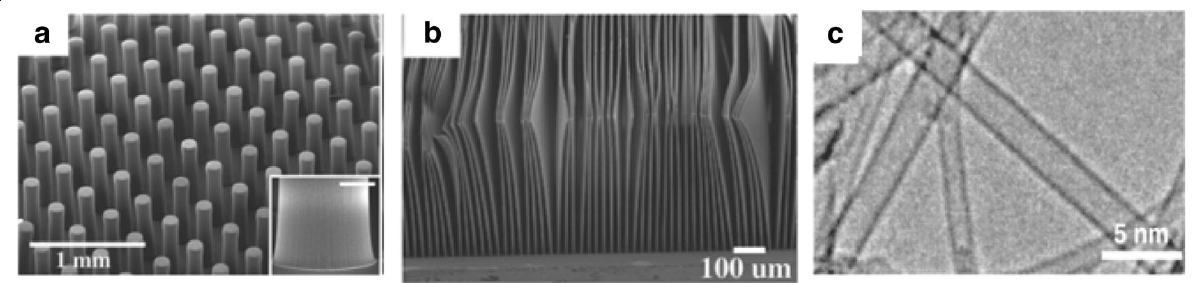
Fig. 31 a , b SEM images of SWCNT forests grown using water assisted CVD. a SWCNT cylindrical pillars with 150 μ m radius and ~1 mm height. Insert shows the root of a pillar. Adapted from [135]. b SWCNT sheets of 10 μ m thickness. Adapted from [135]. c High-resolution TEM image of the SWCNTs grown using this method. Adapted from [135]